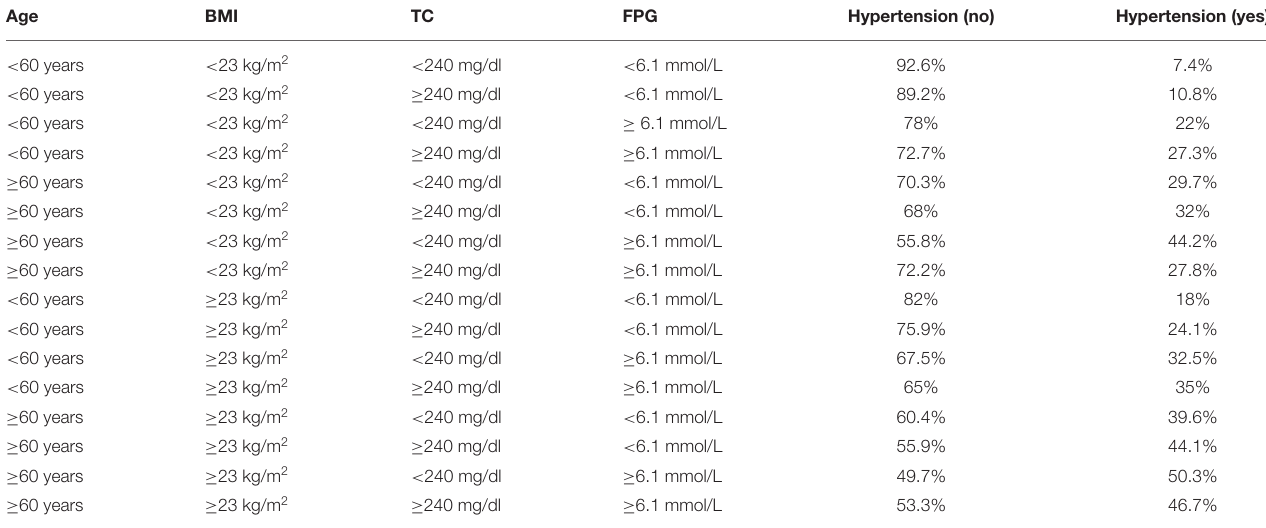
TABLE 4 | Conditional probability table of